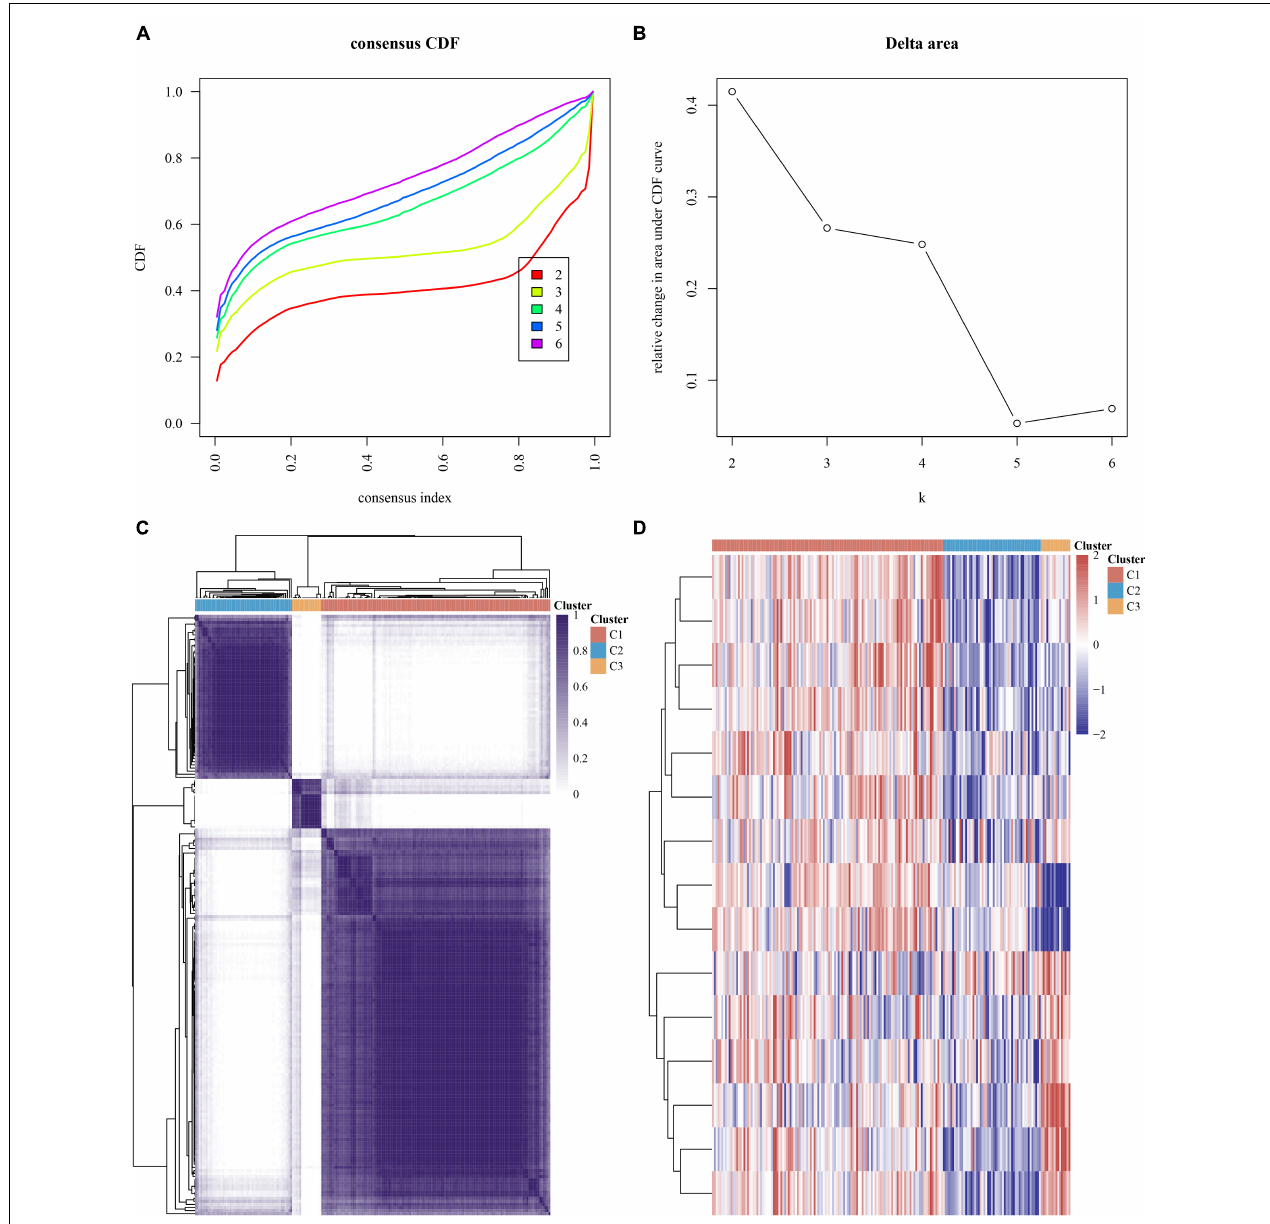
FIGURE 4 | Consensus clustering analysis of MI samples based on mRNA levels of m6A regulators. (A) Cumulative distribution function of clustering (k, 2–6). (B) Delta area score displayed relative growth in cluster stability. (C) Consistency matrix of sample with k = 3. (D) Heatmap of expression of m6A regulators in three types of